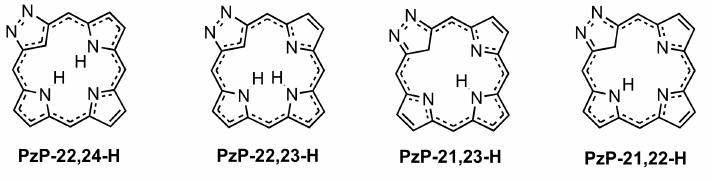
Figure 3. Proposed aromatic circuits in selected pyrazoloporphyrin